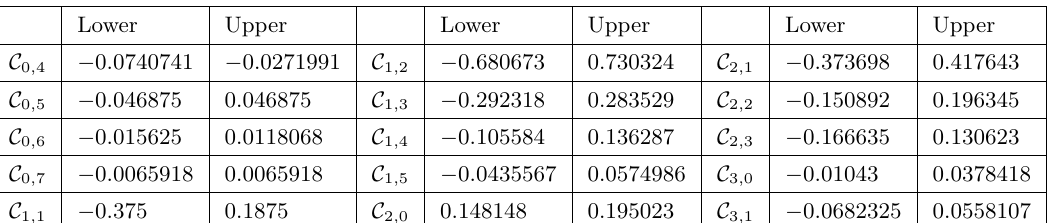
= 1 in our normalization. Also note that C 1 , 0 can’t be bounded. In order to restore the normalization 0 , 0 one would have to replace c W ( k ) 1 , 0